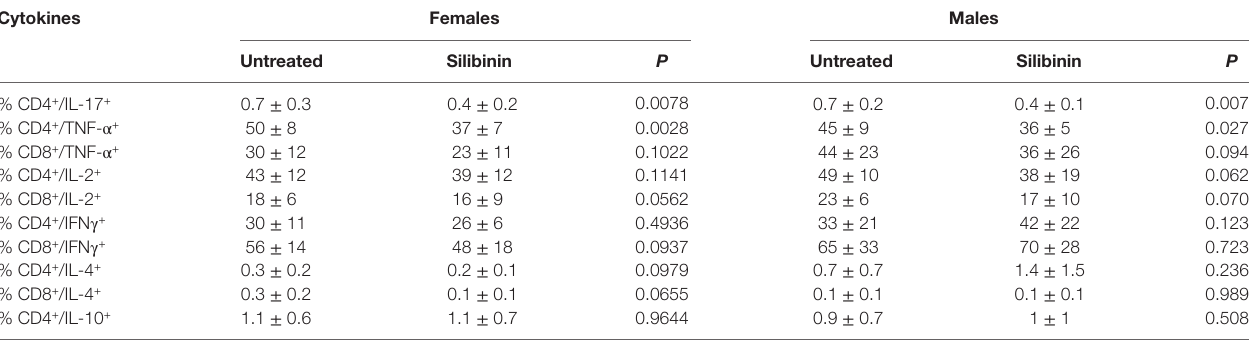
Table 2 | Cytokine expression at the single cell level by flow cytometry analysis of CD4 + and CD8 + T lymphocytes from female and male healthy donors. cytokines Females Males Untreated silibinin P Untreated silibinin % CD4 + /IL-17 + 0.7 ±